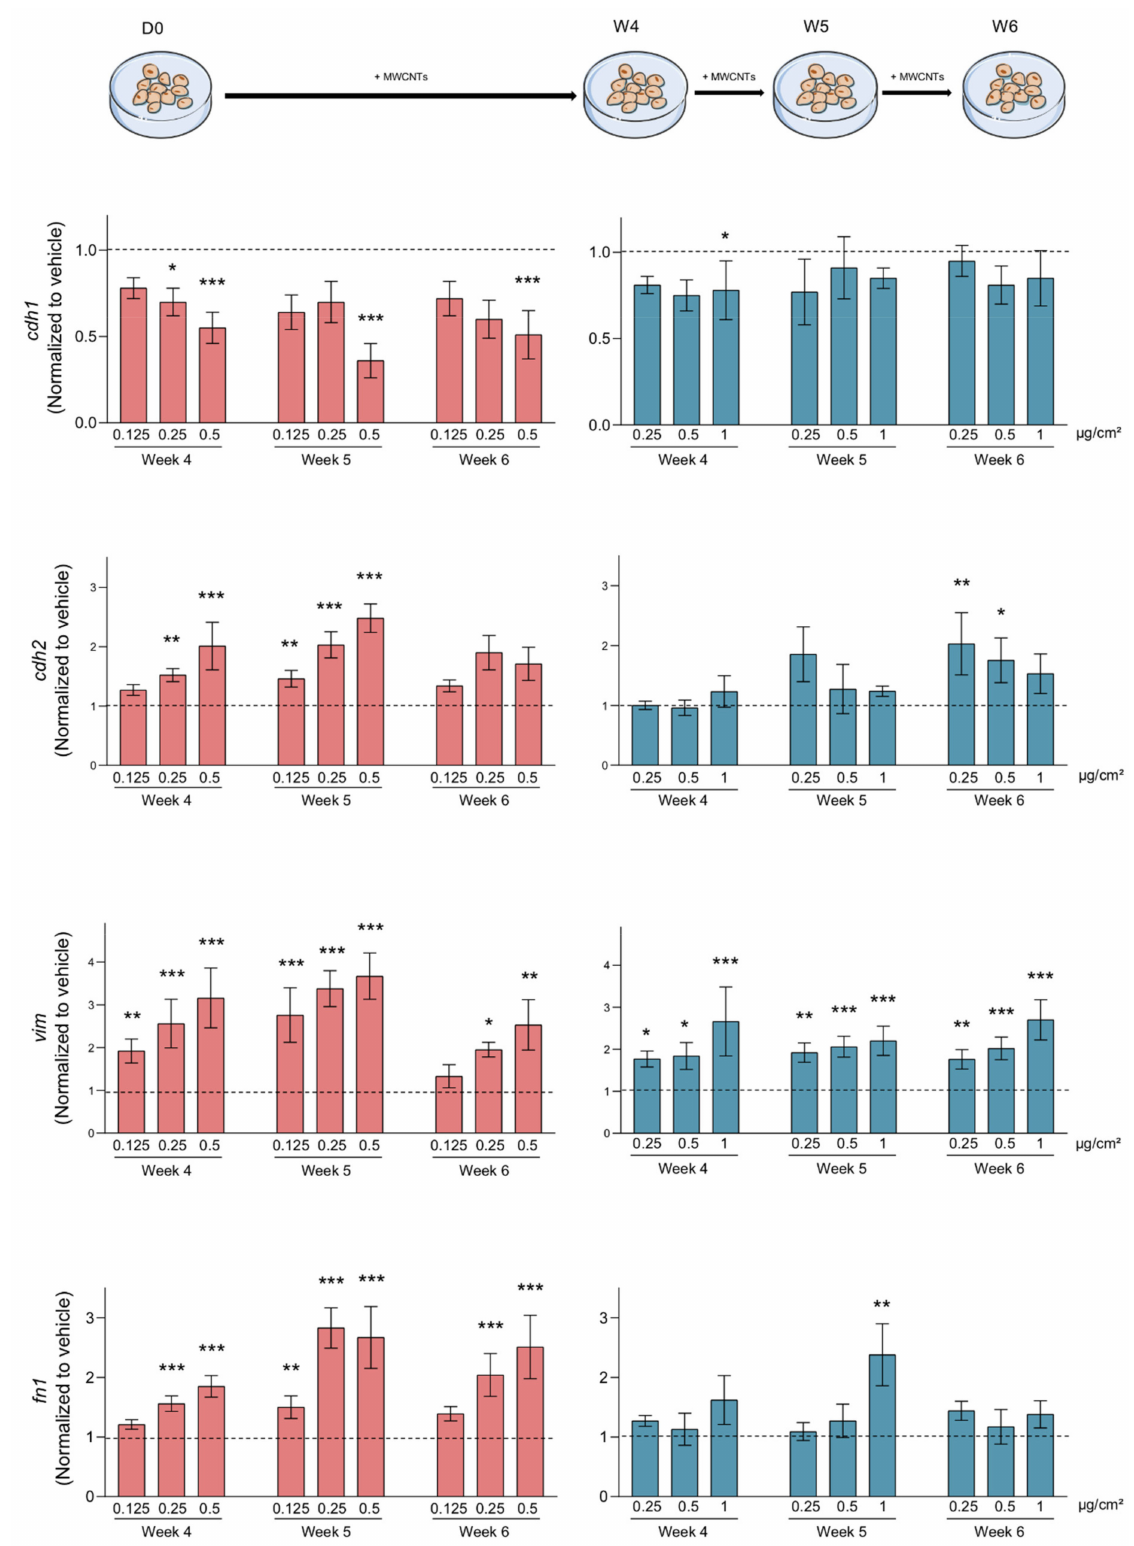
Figure 7. MWCNTs-induced EMT marker expression. RNAs from total cells treated with the indicated concentration of Mitsui-7 ( left ) or NM-403 ( right ) were extracted and gene expression was analysed using RT-qPCR. The epithelial marker E-cadherin ( cdh1 ) and mesenchymal markers N-cadherin ( cdh2 ), Vimentin ( vim ) and Fibronectin ( fn1 ) were evaluated after 4, 5 and 6 weeks of treatment. The histograms represent the mean ± standard error of the mean (SEM) for three independent experiments. * p < 0.05, ** p < 0.01, *** p < 0.001 significantly different from the